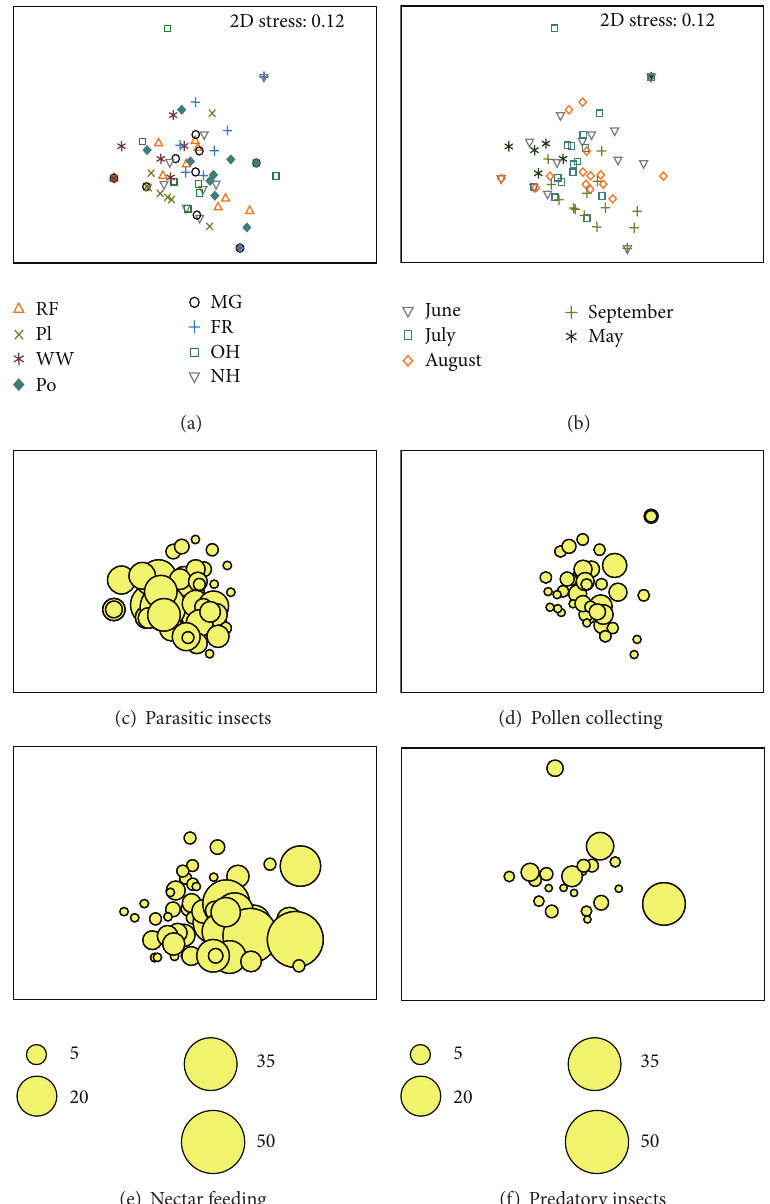
Figure 2: (a) Multidimensional Scaling (MDS) plot of flower visiting guilds at each of the eight sites based on Bray-Curtis similarity. (b) MDS plot of flower visiting guilds at each of the five sampling month based on Bray-Curtis similarity. ((c)–(f)) Bubble plot overlaid on the MDS sample points indicating patterns driven by the abundance of each guild. These highlight the role of each guild in shaping the community, bubble size relative to the number of individuals at that